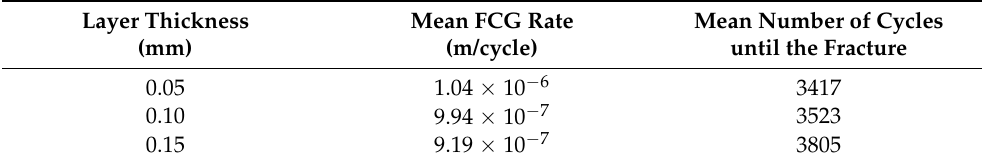
Figure 10. Comparison between layer thickness influence on FCG rate of FDM ABS samples with (0.4-, 0.6-, and 0.8-mm nozzle size, and X, XY, and Y building orientation) under 50, 60, 70 °C environmental temperatures. Table 6. The mean FCG rate and number of cycles of different layer thicknesses regardless of other printing parameters.